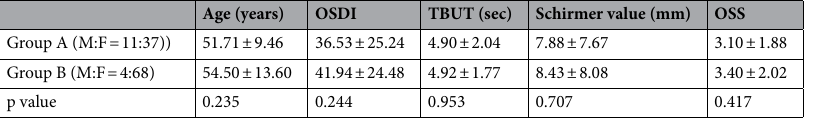
Table 1. Ages and dry eye clinical parameters of the two groups. Independent t-test. OSDI Ocular Surface Disease Index, TBUT tear break up time, OSS ocular staining score.